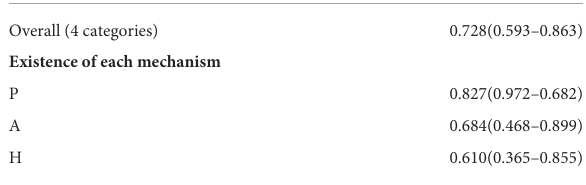
TABLE 2 Intraobserver reproducibility of stroke mechanism